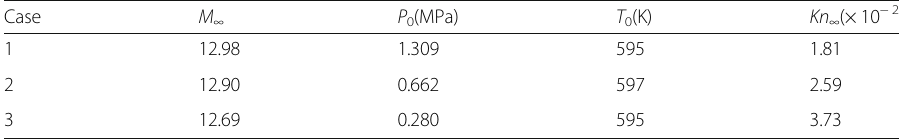
Table 2 The test cases for the Shenzhou reentry capsule Case